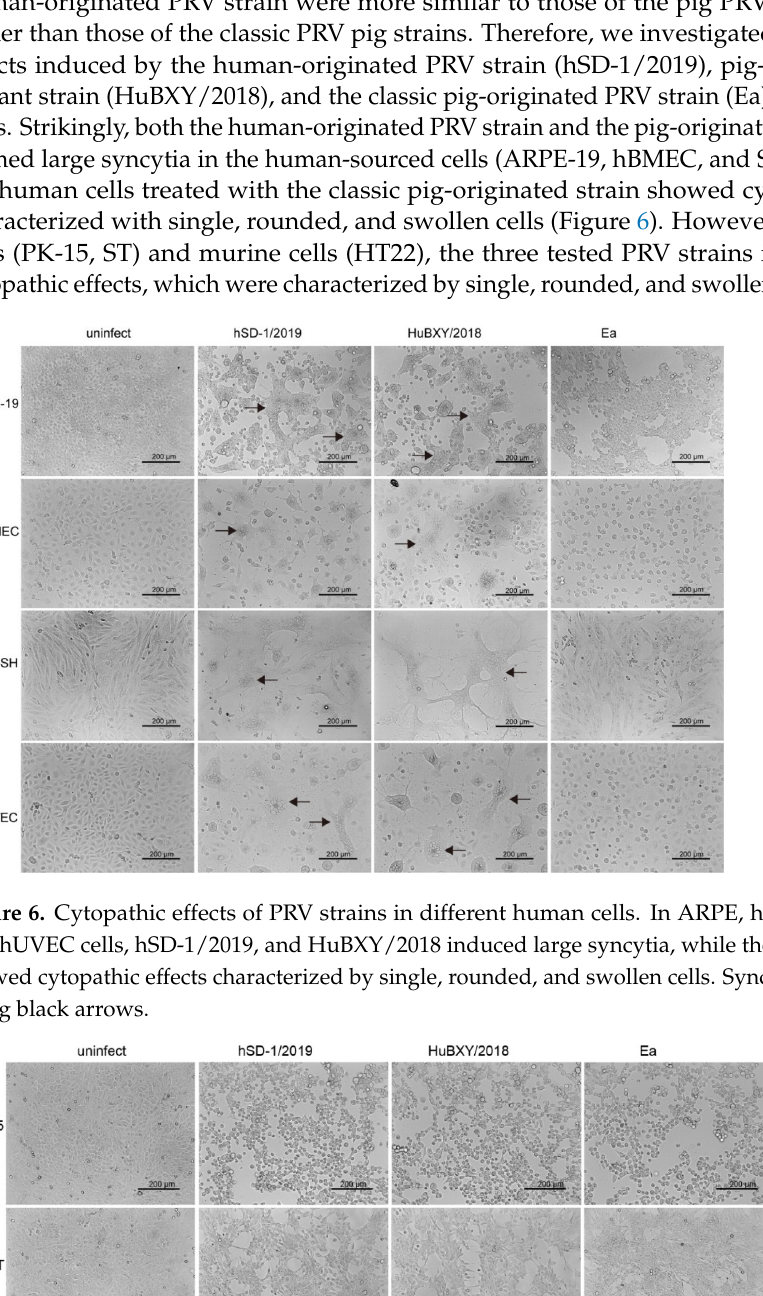
Table 3. Algorithms of the RDP4 package used to predict the recombination event.